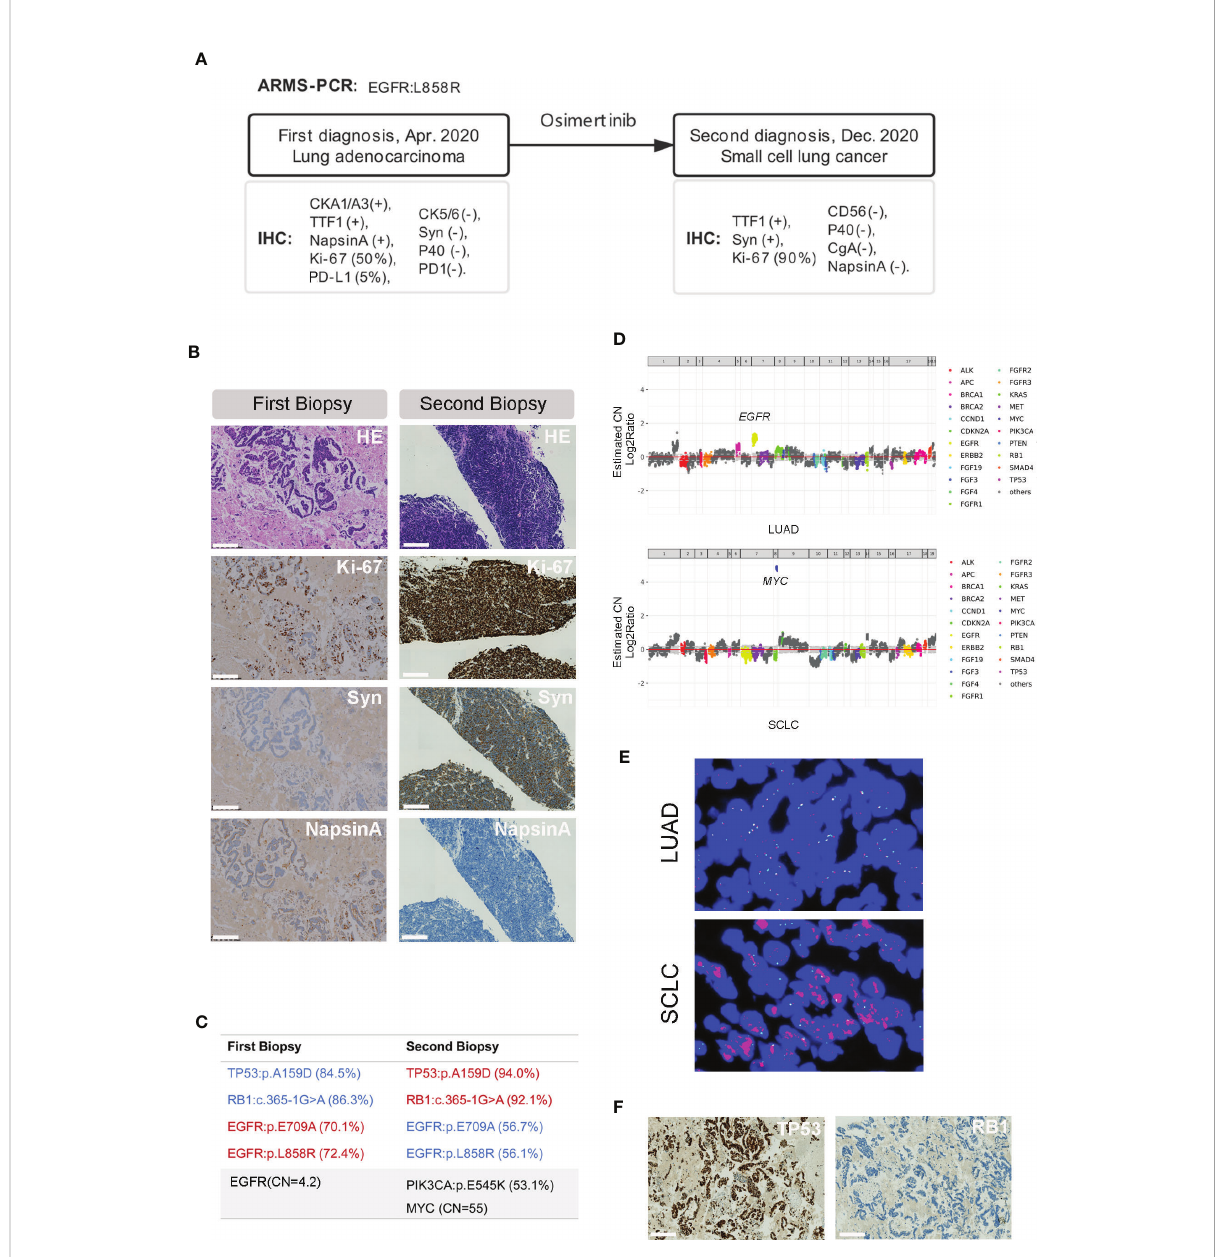
FIGURE 1 Pathology features and genetic aberrations present before and after SCLC transformation. (A) A brief history of the disease diagnosis and treatment in this patient. (B) HE and IHC staining of the tumor tissue before ( fi rst biopsy) and after (second biopsy) the SCLC transformation (10×). Scale bar indicates 200 m m. (C) Genetic aberrations detected in the fi rst and second tumor biopsy tissue using the targeted sequencing covering 56 lung cancer related genes. (D) MYC copy number (CN=55, upper) and EGFR copy number (CN=4.2) determined by modeling copy number variation and aneuploidy across the genome, the Y axis is indicated as log2 scale. (E) Example of MYC ampli fi cation detected by FISH in the primary LUAD (upper) and transformed SCLC (lower) tissue (40×). (F) IHC staining pattern of TP53 and RB-1 in the LUAD biopsy before transformation (10×). Scale bar indicates 200 m